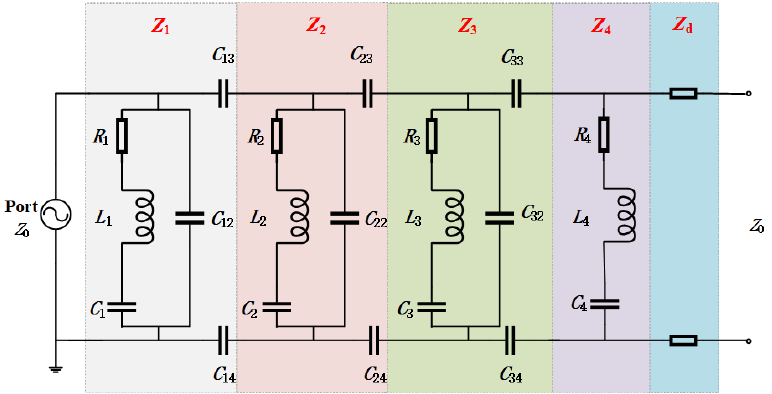
( b ) Figure 8. Simulated absorptance with different values of t 3 : ( a ) TE wave; ( b ) TM wave.